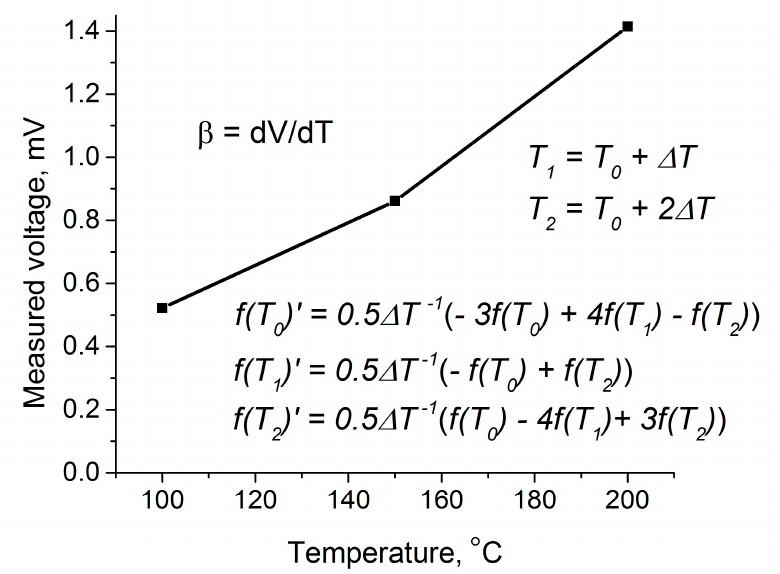
Figure 9. Dependence of the potential difference on the temperature.